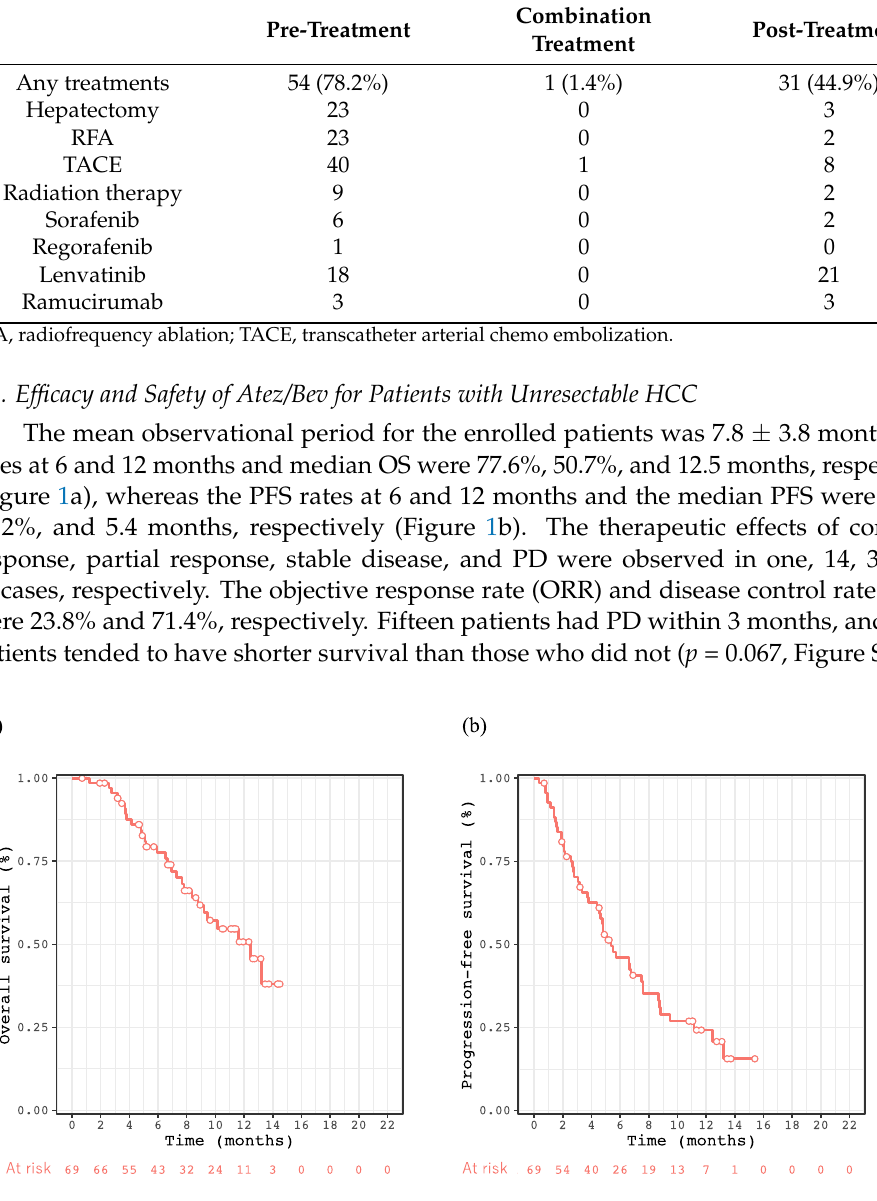
Table 3. Adverse events during atezolizumab plus bevacizumab treatment.